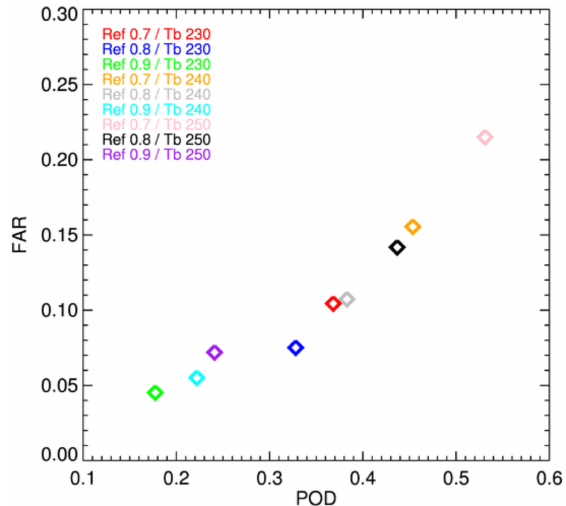
Figure 10. Plot of probability of detection (POD) and false alarm ratio (FAR) for different combinations of T b and reflectance thresh- olds. The texture threshold of 0.4 and 0.9 are kept